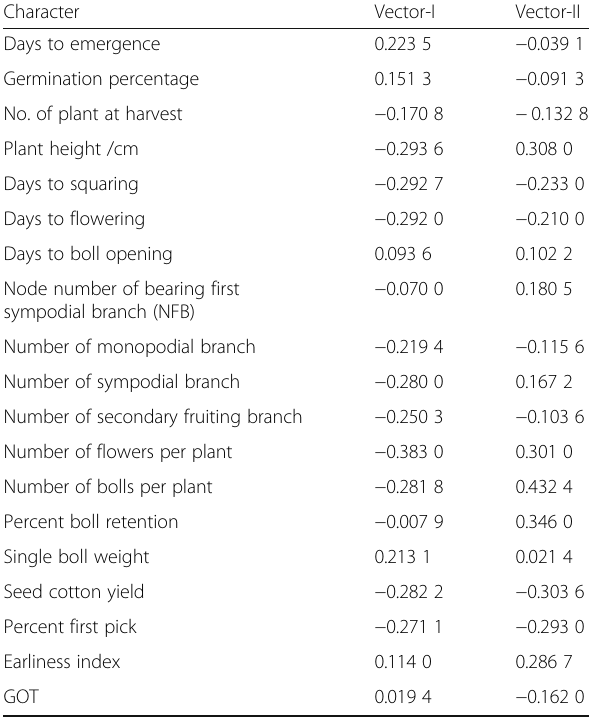
Table 5 Relative contribution of 19 characters of cotton